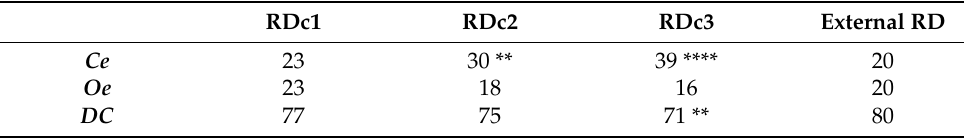
Figure 3. Distribution of the FireCCI51 accuracy metrics across the 60 sites obtained with the external reference dataset and the three reference data collections. Table 1. FireCCI51 overall accuracy metrics (%) derived from the four reference datasets in the 60 selected sites within the RAISG study area. The level of significance between the accuracy metrics obtained from each RDc with respect the external RD is labelled by ** ( p -value < 0.01) and **** ( p -value < 0.0001).